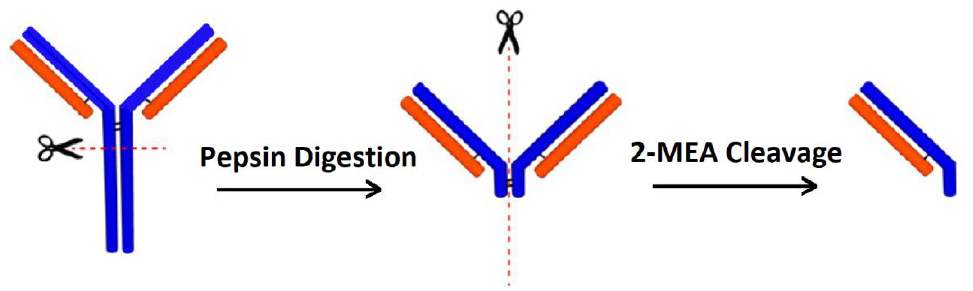
Figure 5. Schematic sketch illustrating the fragmentation of antibody molecule. Enzyme pepsin is used to cut the lower portion of the antibody. 2-mercaptoethylamine (2-MEA) is used as a reducing agent for further fragmentation. Reprinted with permission from [60], Copyright © 2012, American Chemical Society.